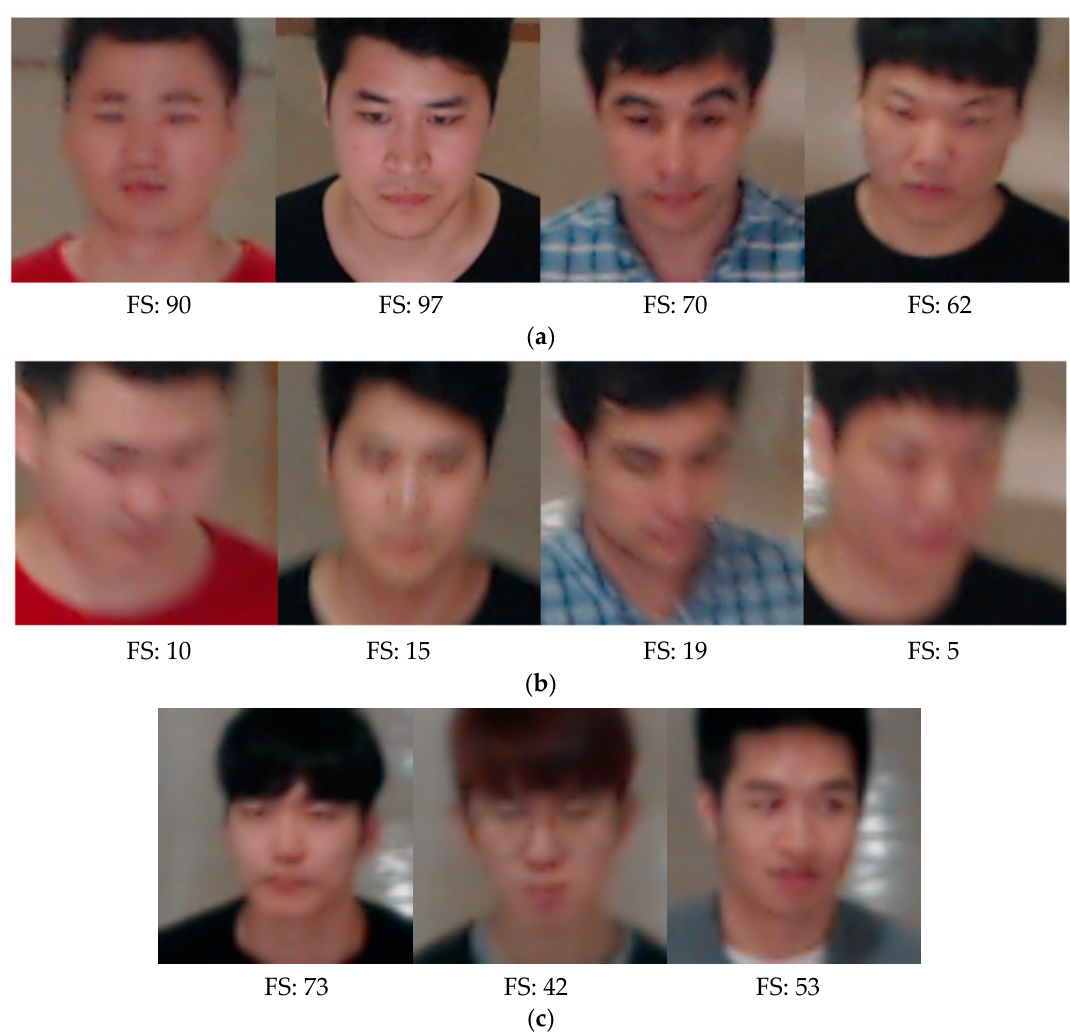
Figure 4. DFB-DB focus score calculation example images: ( a ) Examples of images with a focus score (FS) above the threshold (20) (BCC950 camera images). ( b ) Examples of images with a focus score below the threshold (BCC950 camera images). ( c ) Examples of images with a focus score above the threshold (20) (C920 camera images).